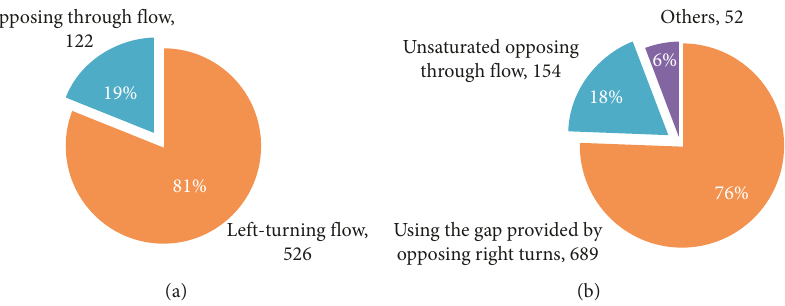
Figure 4: Field surveyed results. (a) The flow crossing the intersection when the permitted phase start. (b) The reason why an acceptable gap for left-turn appears.